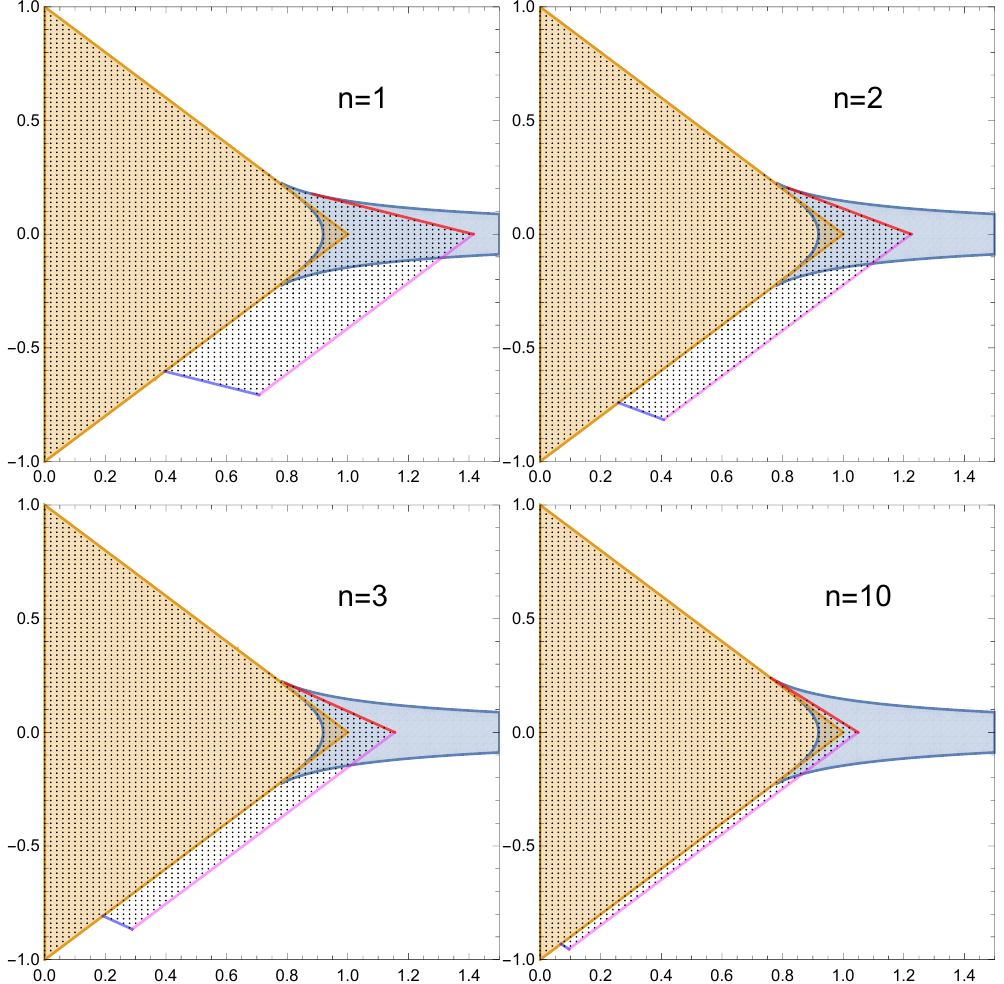
Figure 2 . The unbalanced L ( n, 1) black lens solution projected to the ( j 1 , j 2 ) plane (black dots). The shaded regions correspond to the Myers-Perry black hole (orange) and balanced black ring (blue). The line segments for j 2 < 0 are (4.3) (blue, pink) and for j 2 > 0 is (4.5)